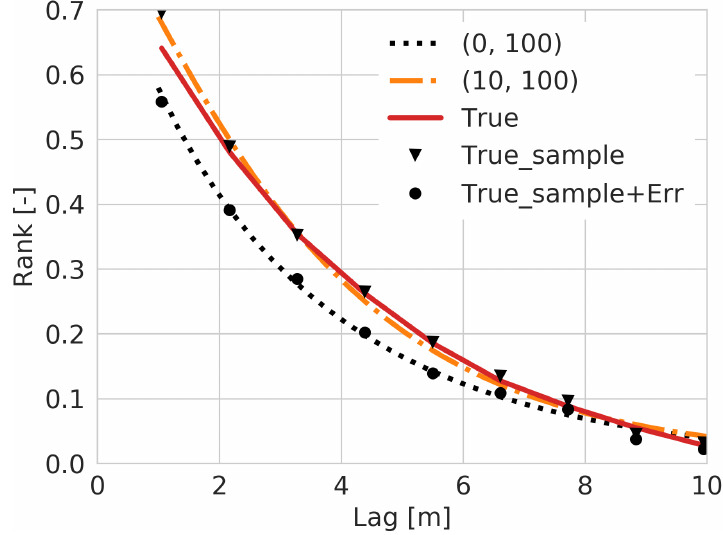
Figure 11. Comparison between the Gaussian copula parameter estimation with 10% left side detection limit (orange dash-dotted lines with label “(10,100)”), without the detection limit (black dot line with label “(0,100)”) and the rank correlations of true domain with 10,000 points (red solid line with label “True”), a sample of the true domain with 2500 points (black inverted triangles with label “True_sample”) and the sample with a Gaussian noise (black dots with label “True_sample+Err”) by using a simulated log-normal Gaussian